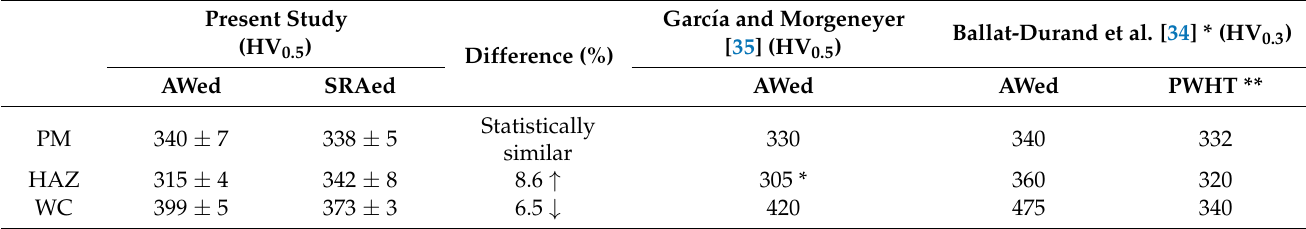
Table 3. Average hardness of WC (peak), HAZ (minima), and PM in the Ti-6242 linear friction welds. Present